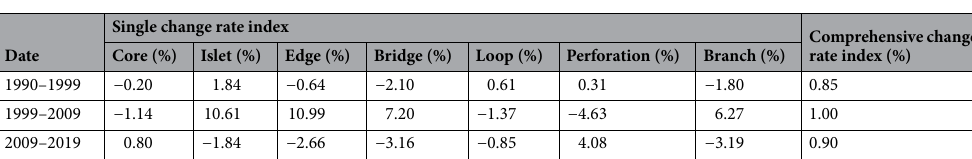
Table 1. Single and comprehensive change rate index of UGI in Beijing from 1990 to